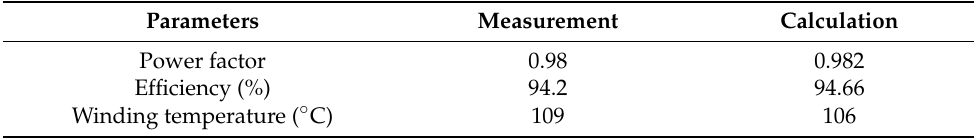
Table 6. Comparison of measured and calculated performance